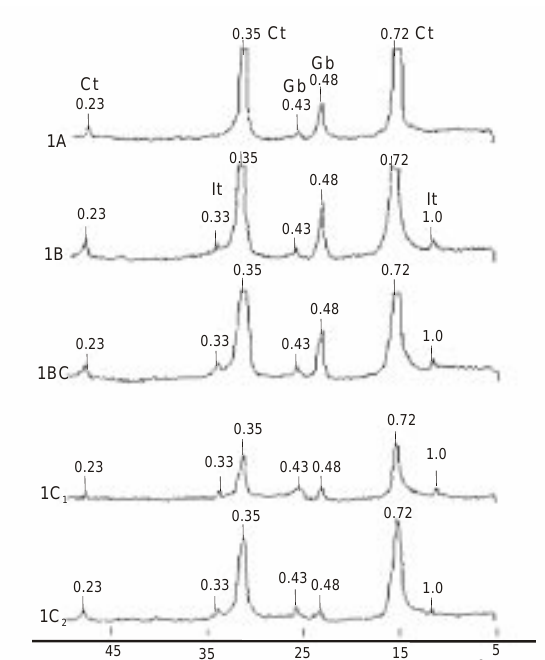
Figura 3. Difratogramas de raios-X da fração argila desferrificada para o perfil 2 – PVe (espaça- mento d em nm) (Ct = caulinita, Gb = gibbsita e It =